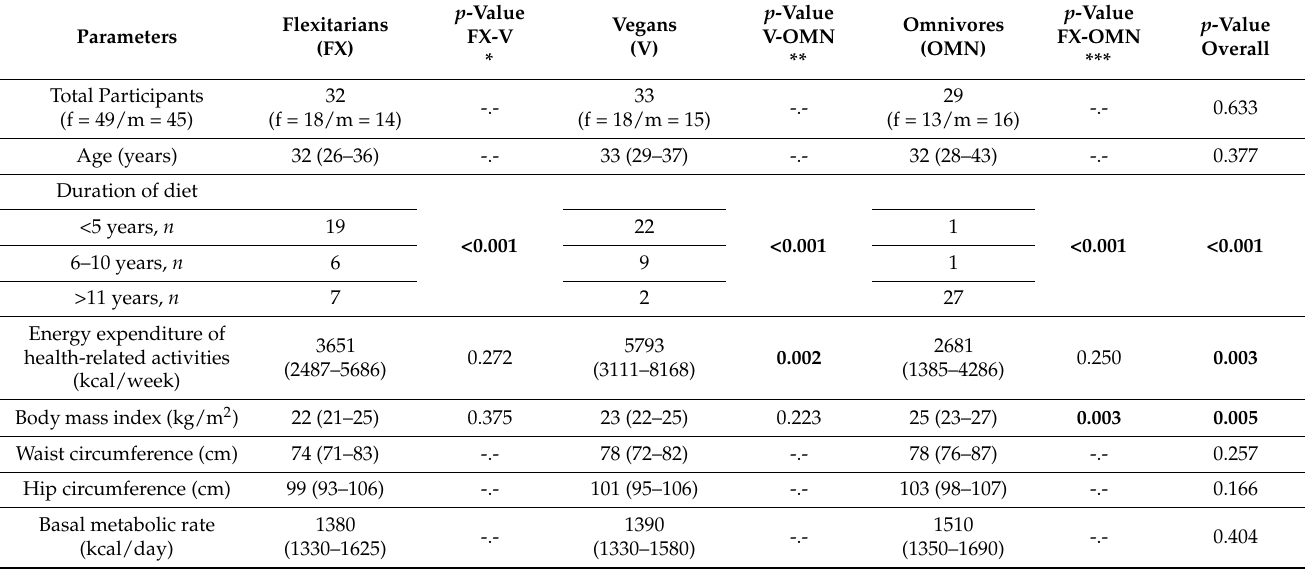
Table 2. Characterization of the study